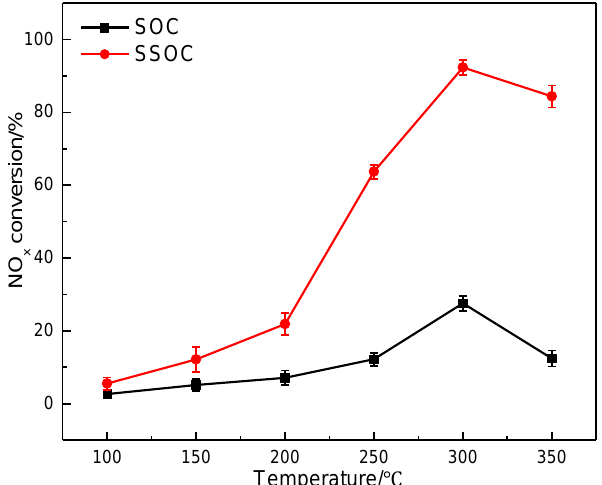
Figure 9. Effect of temperature on SCR activity on SOC and SSOC. 300 ppm NO, 15% O 2 , Ar as balance gas, NH 3 / NO ratio: 1.0, GHSV: 5000 h − 1 .